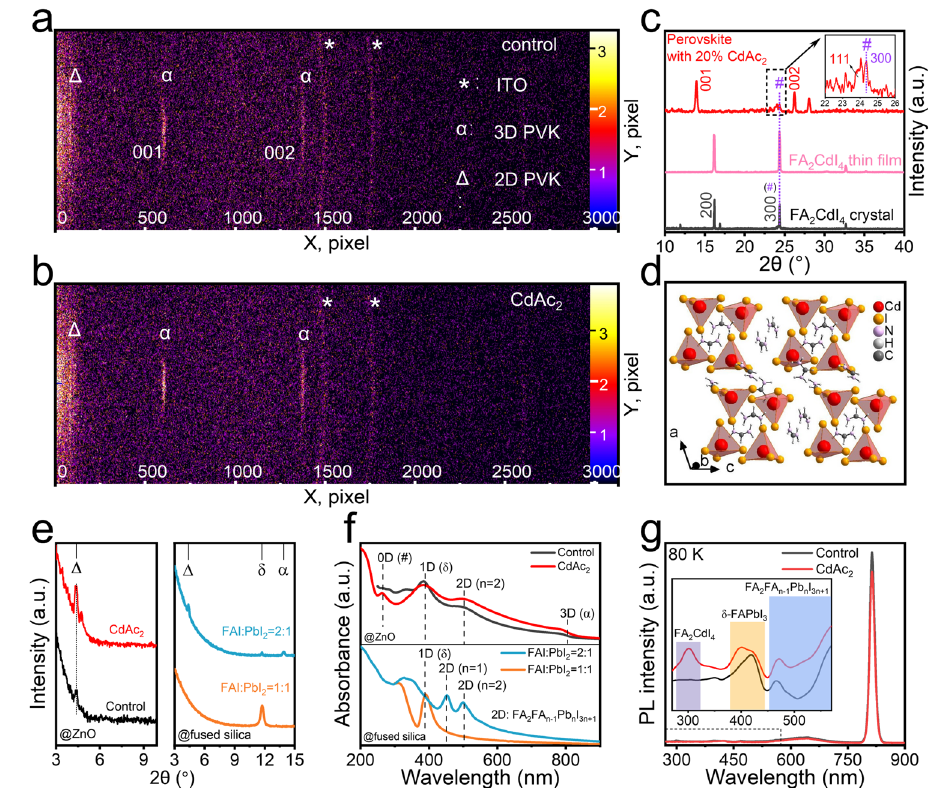
Fig. 2 | stepped-dimensional materials in FAPbI 3 perovskites fi lms. 2D-XRD patterns of the perovskite fi lms a without and b with CdAc 2 additive. c 1D-XRD patterns of the FA 2 CdI 4 crystal, FA 2 CdI 4 thin fi lm, and perovskite fi lm with 20% CdAc 2 . d Crystal structure of 0D FA 2 CdI 4 perovskitoid. e The left plot:1D-XRD patterns of the fi lms without and with CdAc 2 deposited on ZnO/fused silica sub- strates. The right plot: 1D-XRD patterns of the fi lms with the different molar ratios of FAI and PbI 2 deposited on fused silica substrates. f The up plot: UV – vis absorption spectra of the fi lms without and with CdAc 2 deposited on ZnO/fused